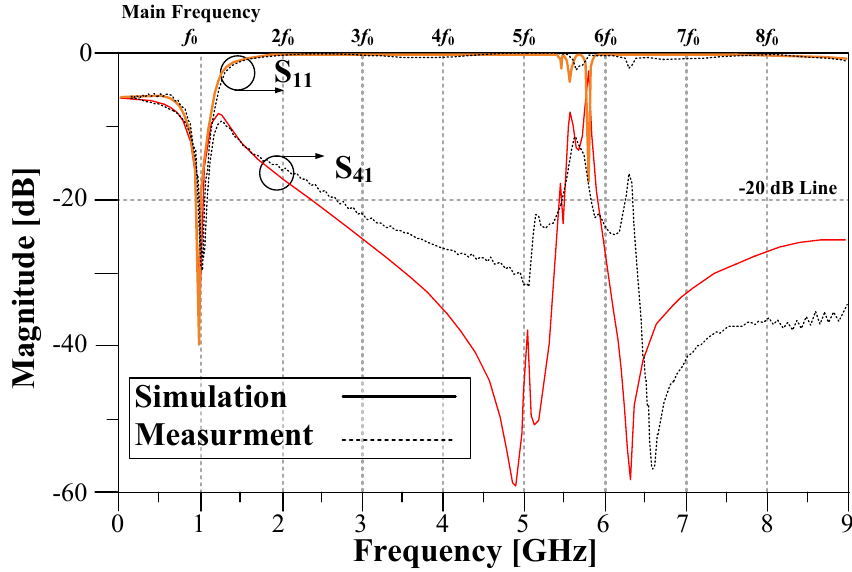
Figure 15. Measured and simulated S 11 and S 41 parameters of the proposed BLC.